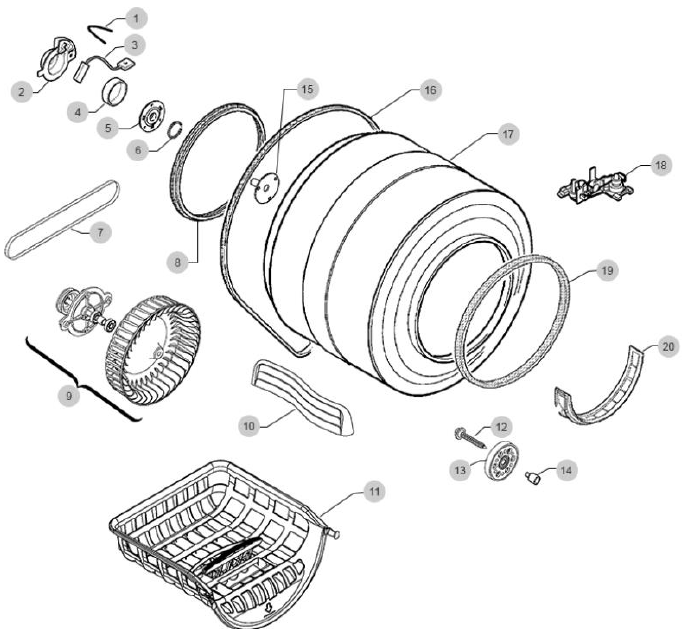
Figure 4. The diagram of North.pl dryer drum where: 1—Spring of the belt tensioner roller, 2—Bearing housing, 3—Motor carbon brush, 4—Engine sleeve, 5—Bearing, 6—Filter gasket, 7—Drive belt, 8—Back cover gasket, 9—Fan impeller, 10—Drum carrier, 11—Drying basket, 12—Bolt, 13—Belt tensioning roller, 14—Belt tensioner roller bushing, 15—Bearing axle, 16—Drive belt, 17—Complete drum, 18—Moisture sensor, 19—Gasket, 20—Engine